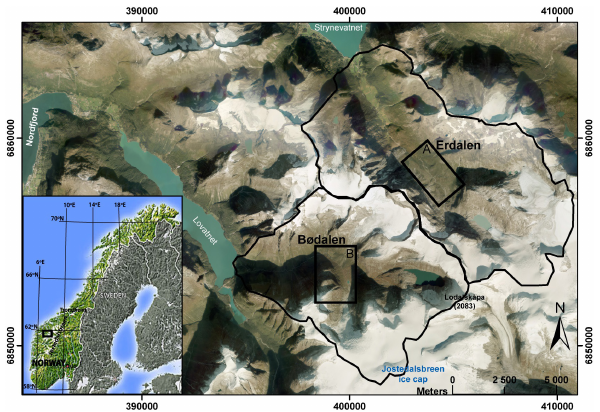
Figure 1. Location of the Nordfjord region (western Norway), aerial photograph of the Erdalen and Bødalen glacial valleys and situation of the study areas.